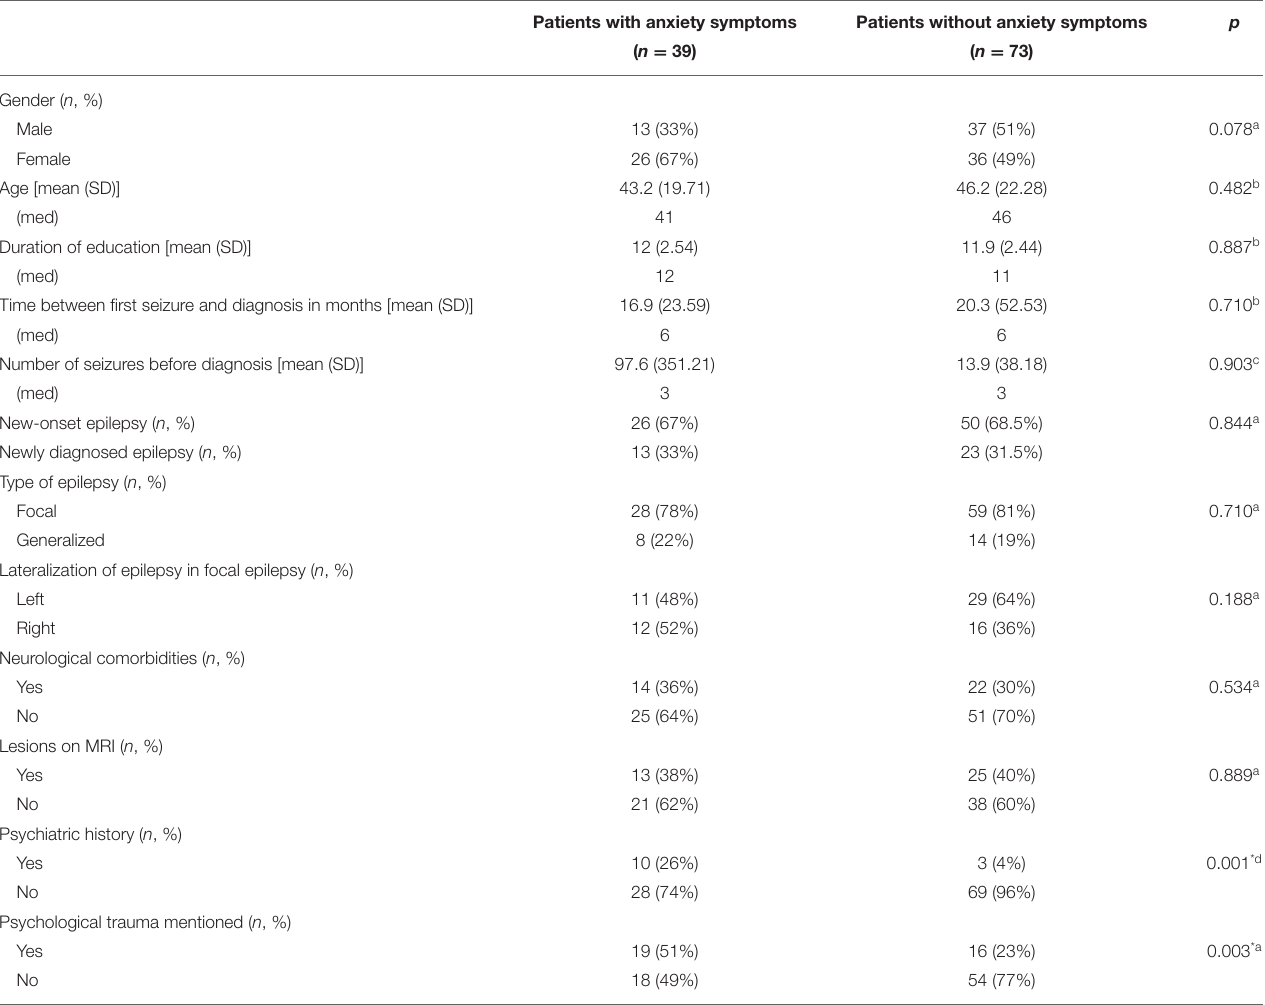
TABLE 2 | Sociodemographic and medical data according to the presence or absence of anxiety symptoms. Patients with anxiety symptoms Patients without anxiety